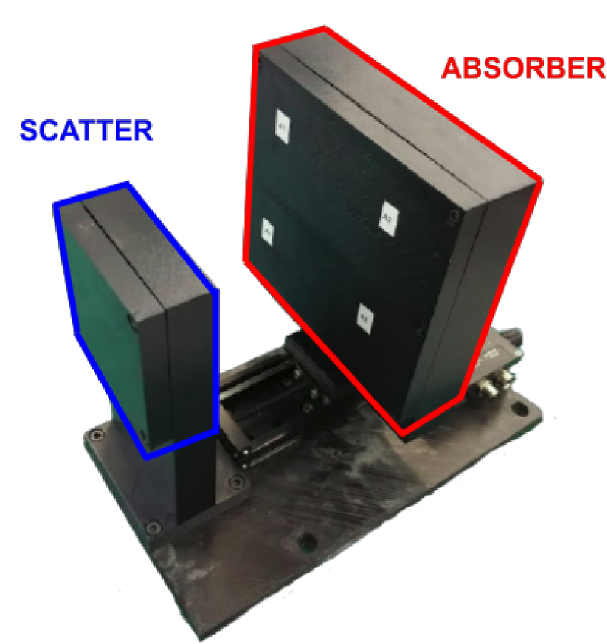
Figure 3. i-TED Compton module composed of one Scatter (50 × 50 × 10 mm LaCl 3 ) and four Absorber (50 × 50 × 25 mm LaCl 3 )